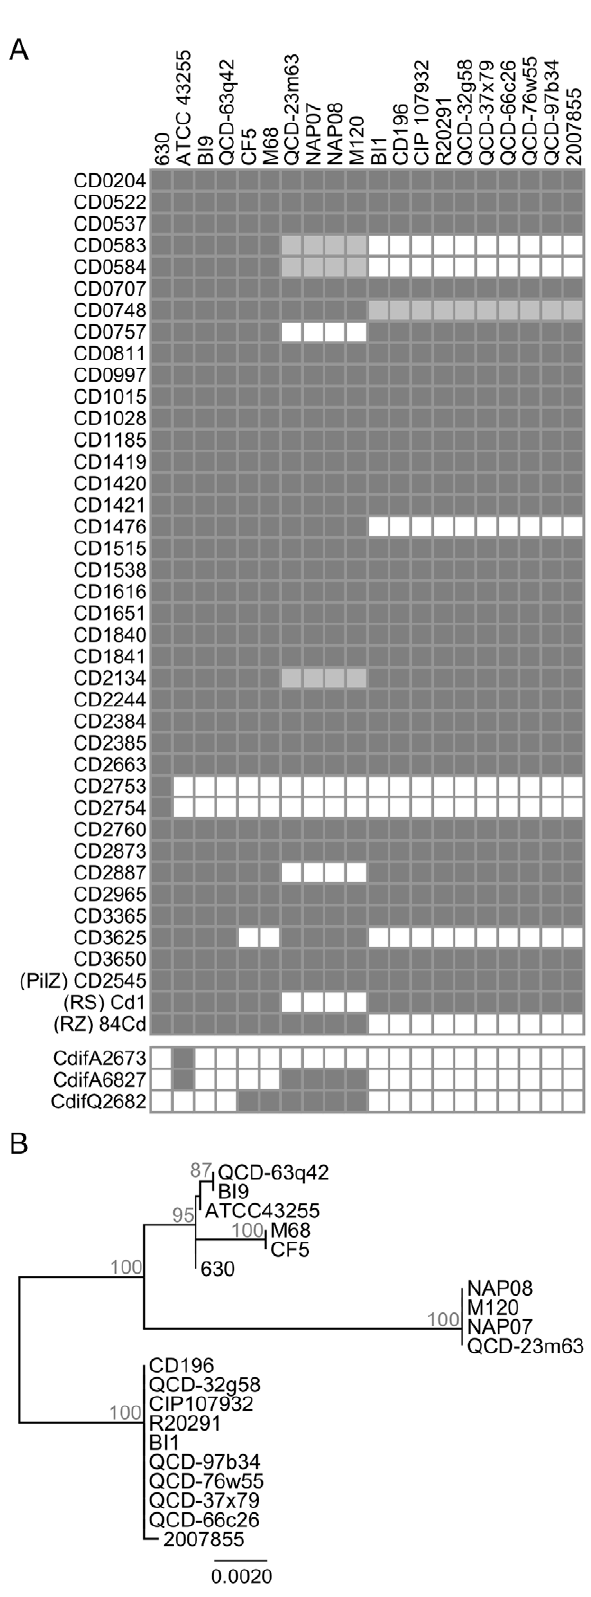
Figure 2. Conservation of c-di-GMP–signalling components of C.difficile 630 in other strains of C.difficile . (A) Protein orthologs exhibiting $ 90% identity are indicated by dark grey boxes. More divergent proteins sharing between 85 and 89% identity or